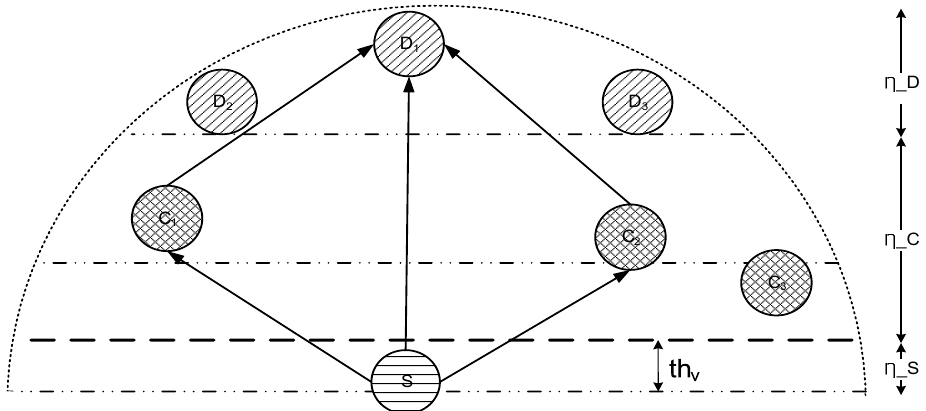
Figure 4. Slicing of transmission range of source